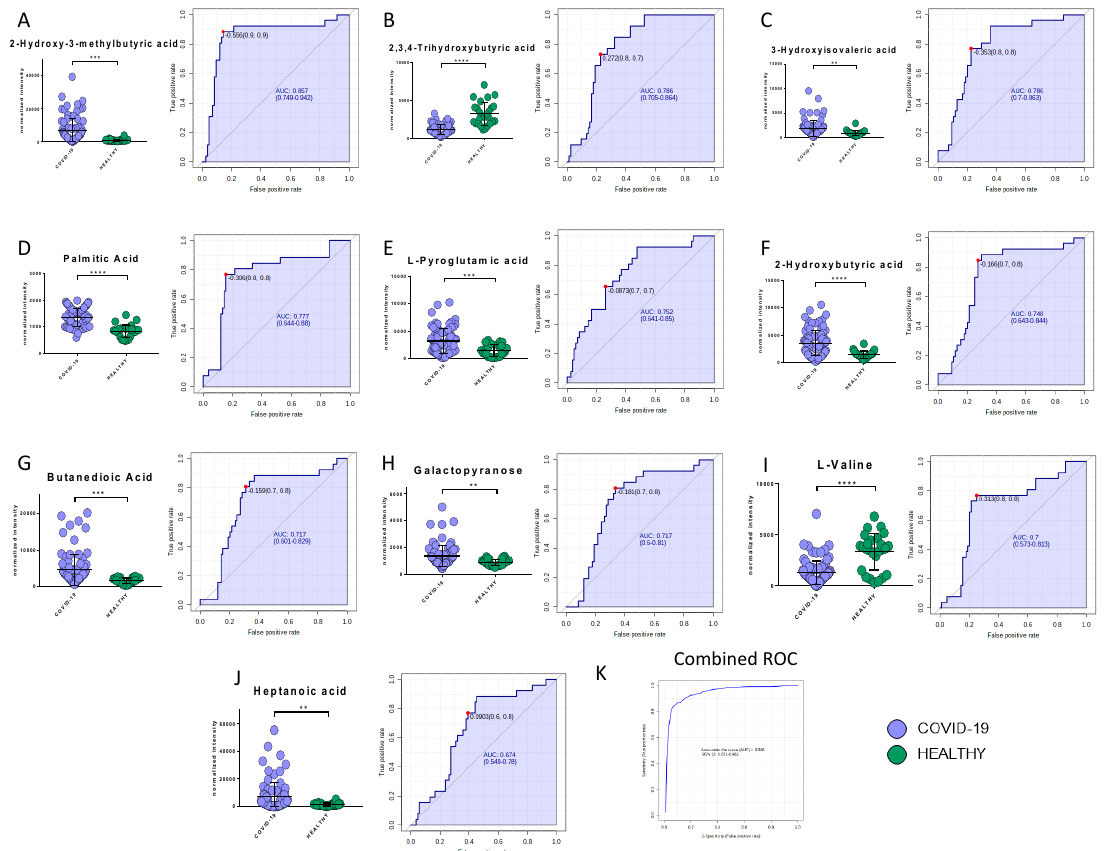
Figure 7. Bar plots (average ± SD) with relative statistical significance ( p -value < 0.01 = **; p -value < 0.001 = ***; p -value < 0.0001 = ****) and ROC curves with the optimal cutoff calculated for each ROC analysis (red dot) are reported in order to show the best potential biomarkers identified using metabolomics analysis: 2-hydroxy-3-methylbutyric acid ( A ), 2,3,4-trihydroxybutyric acid ( B ), 3-hydroxyisovaleric acid ( C ), palmitic acid ( D ), L-pyroglutammic acid ( E ), 2-hydroxybutyric acid ( F ), butanedioic acid ( G ), galactopyranose ( H ), L -valine ( I ), and heptanoic acid ( J ). The combined ROC of the best three molecules (2-hydroxy-3-methylbutyric acid, 2,3,4-trihydroxybutyric acid, and 3-hydroxyisovaleric acid) is also shown ( K ).